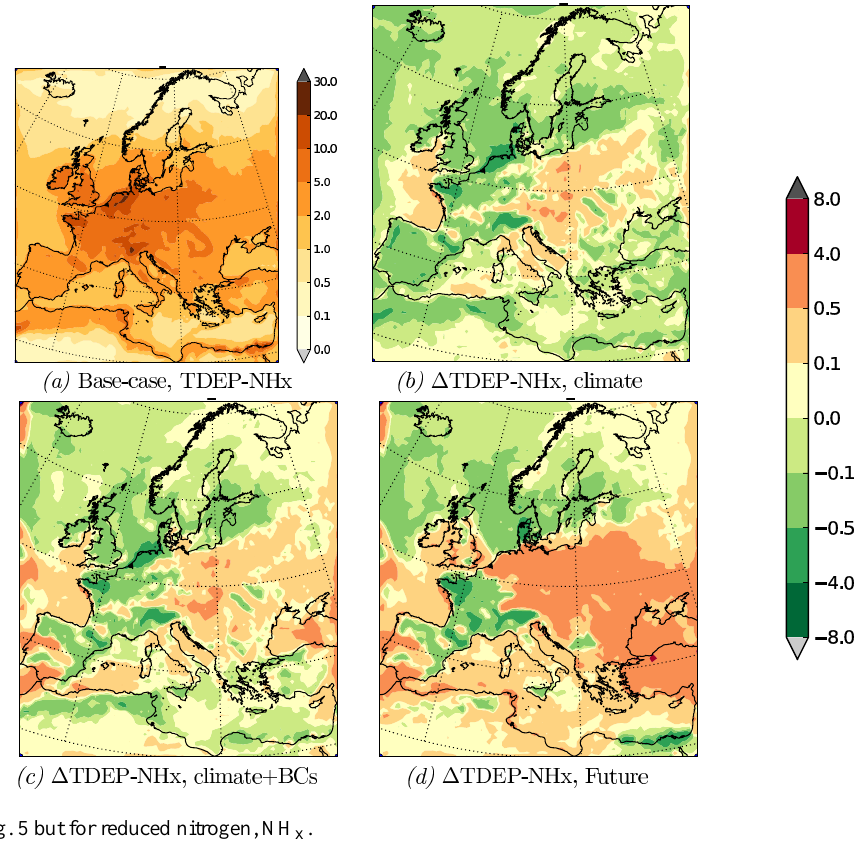
Figure 6. As Fig. 5, but for reduced nitrogen, NH x . Figure 6. Same as Fig. 5 but for reduced nitrogen, NH x .